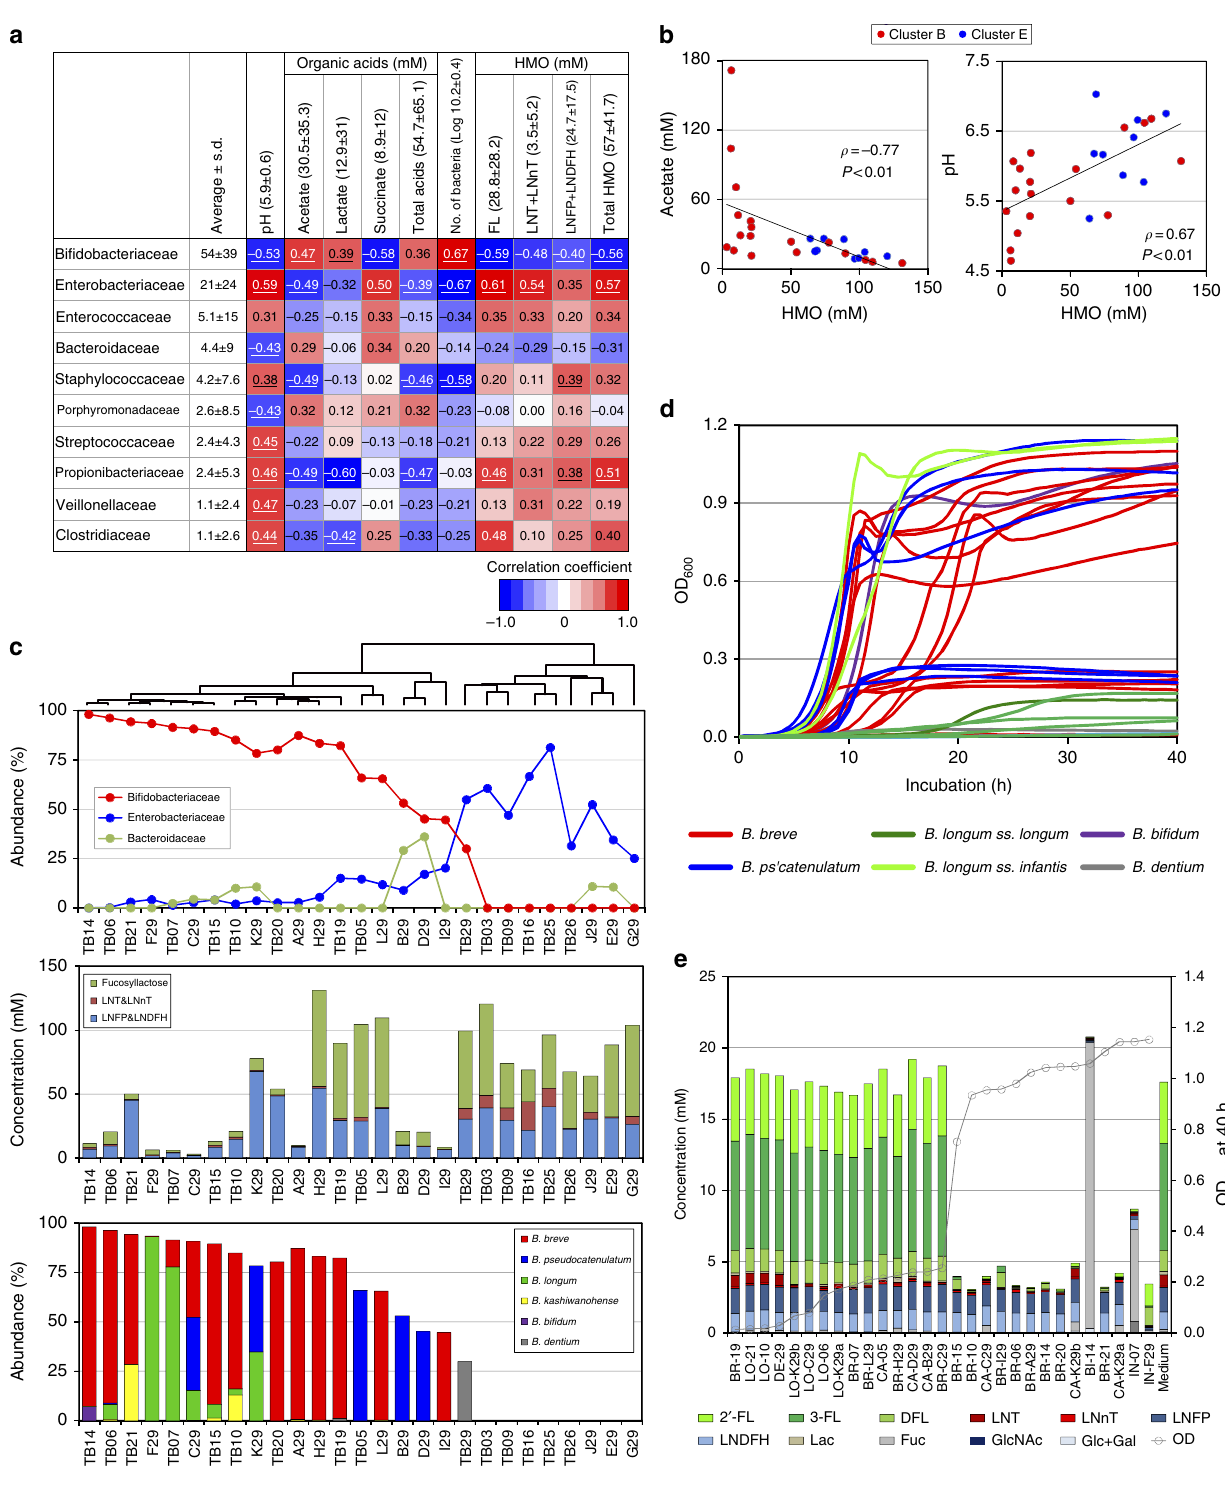
Figure 3 | Relationships between bacterial family abundances and gut environments. ( a ) Spearman’s rank correlation coefficients between bacterial family abundances and gut environmental factors such as pH, organic acid concentrations and faecal oligosaccharide concentrations are shown in numerical and colour-scale formats. ( b ) Spearman’s rank correlations of oligosaccharide concentrations with pH values and acetate concentrations. ( c ) Relationships between bacterial abundances, faecal oligosaccharide concentrations and the relative abundances of bifidobacterial species. The upper tree shows hierarchical clustering on the basis of the bacterial family compositions. ( d ) Growth curves of 29 bifidobacterial strains in medium containing HMOs (see Supplementary Fig. 14 for more details). ( e ) Glycoprofiles of bacterial supernatants after 40h of cultivation. Samples are ordered based on their OD 600 values after 40h of